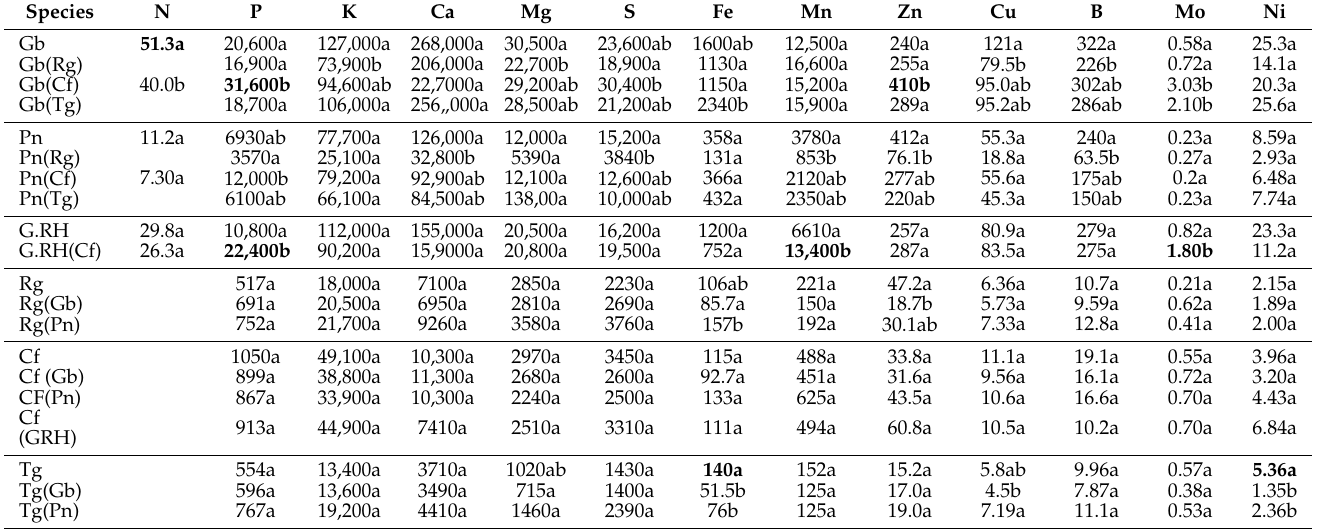
Table A3. The total foliar uptake ( µ g) of each nutrient by each of the six species according to whether they were growing alone or with a companion species. (Gb: Grevillea barklyana , Pn; Protea neriifolia , G.RH; Grevillea Robin Hood, Cf, Cocksfoot; Rg, Ryegrass; Tg, Tussock grass). Different letters each indicate significant differences ( p < 0.05) within each treatment. Bold alphanumericals indicate significant differences to when the species was growing alone. Minimum detectable limits of Mo (0.02 mg kg − 1 ) were used for uptake calculations of this